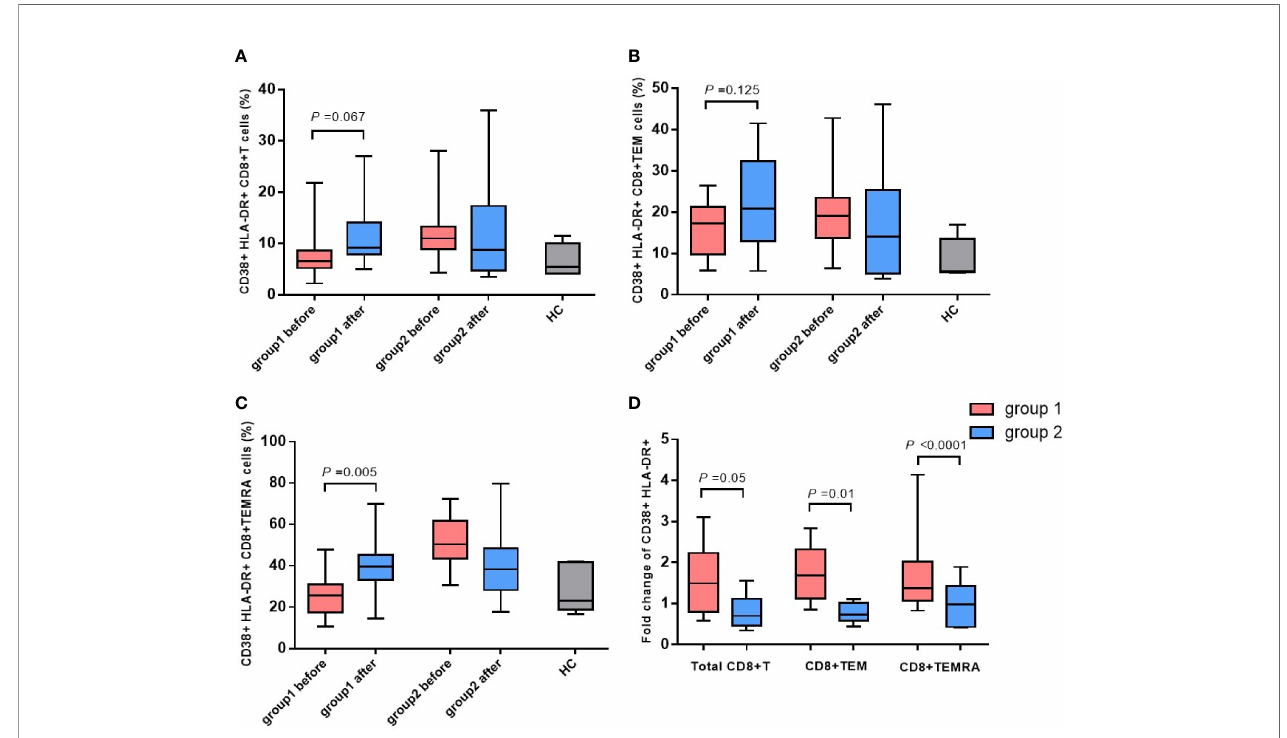
FIGURE 3 | The changes in CD38 and HLA-DR expressed CD8 + T cells and phenotypic subsets. Expression of CD38 and HLA-DR on CD8 + T cells (A) , TEM subsets (B) and TEMRA subsets (C) before and after childbirth between the group 1 and group 2. Fold change of activation of CD8 + T cells, TEM subsets, and TEMRA subsets after childbirth between the group 1 and group 2 (D) .